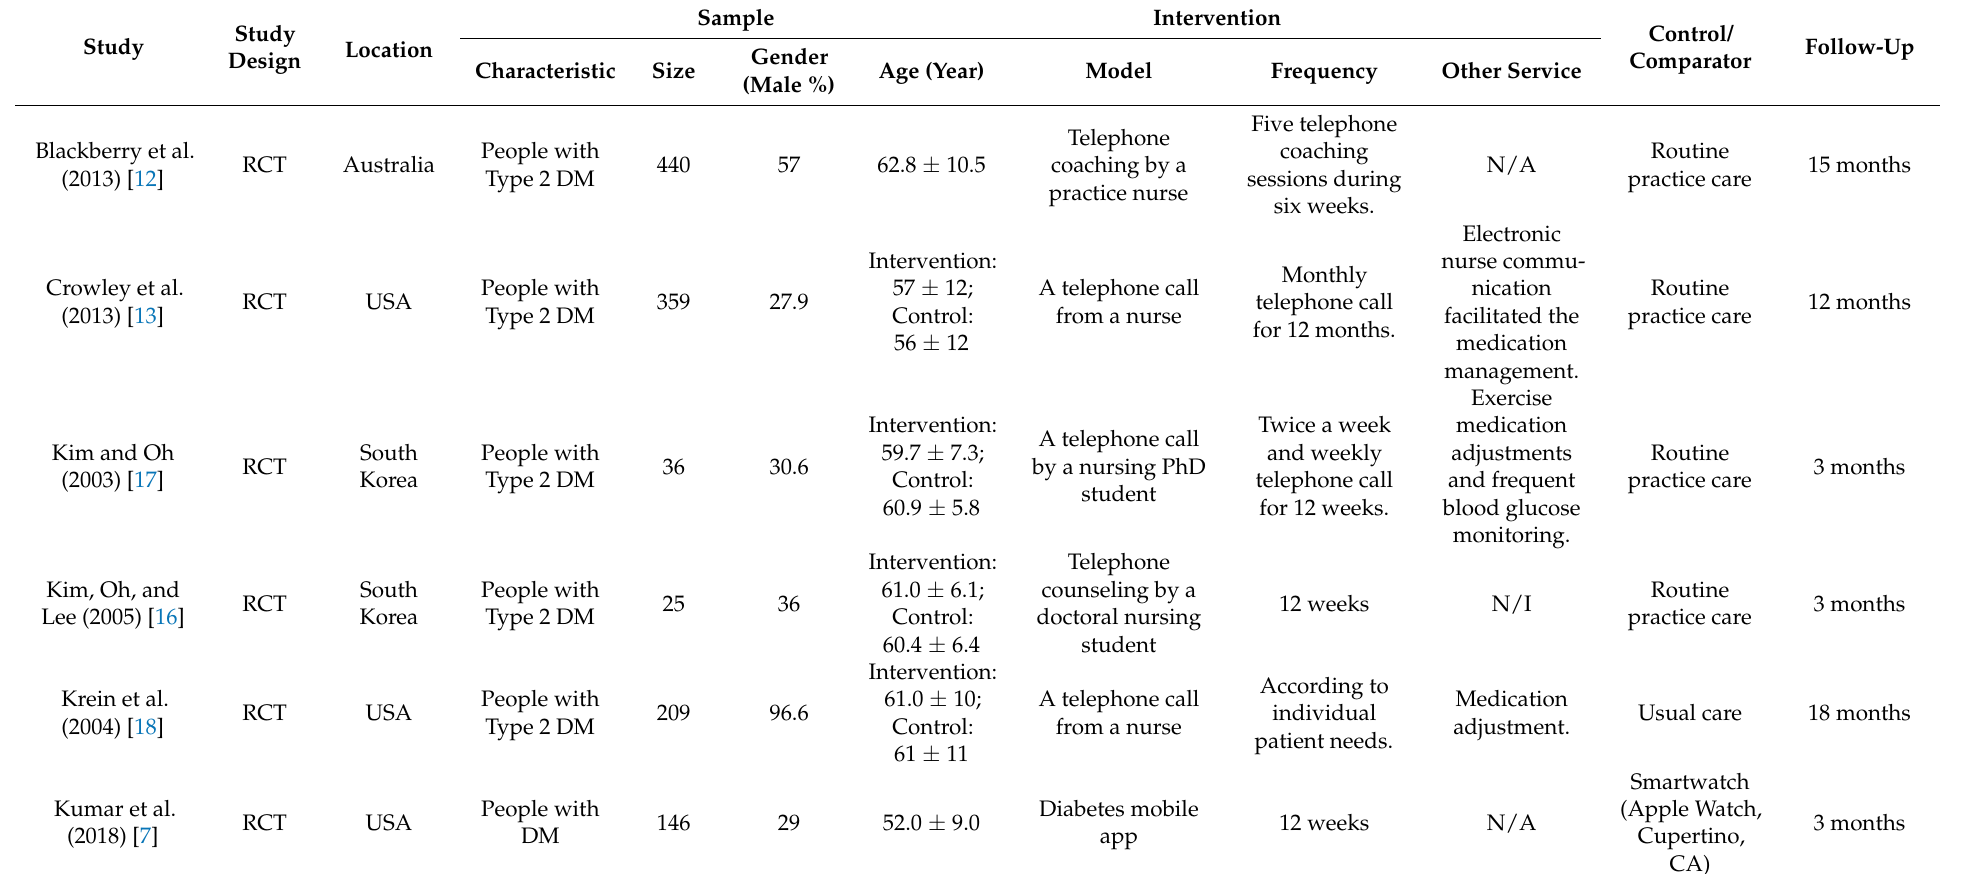
Table 1. Characteristics of Included